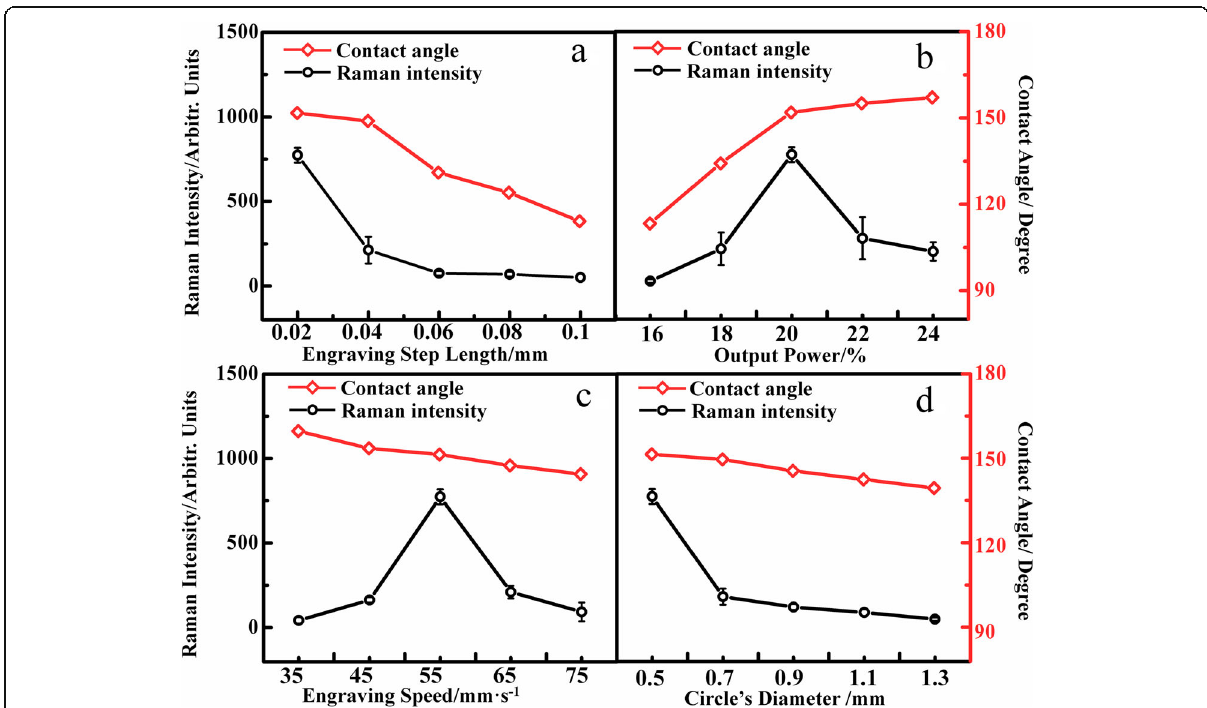
Fig. 4 a The relation between the contact angle, Raman intensity, and the engraving speed (the output power: 20%; the engraving speed: 55 mm/s; the circle ’ s diameter: 0.5 mm; the Ag concentration: 1.19×10 − 12 M). b The relation between the contact angle, Raman intensity, and the output power (the engraving step length: 0.02 mm; the engraving speed: 55 mm/s; the circle ’ s diameter: 0.5 mm; the Ag concentration: 1.19×10 − 12 M). c The relation between the contact angle, Raman intensity, and the engraving speed (the engraving step length: 0.02 mm; the output power: 20%; the circle ’ s diameter: 0.5 mm; the Ag concentration: 1.19×10 − 12 M) d The relation between the contact angle, Raman intensity, and the circle ’ s diameter (the engraving step length: 0.02 mm; the output power: 20%; the engraving speed: 55 mm/s; the Ag concentration: 1.19×10 − 12